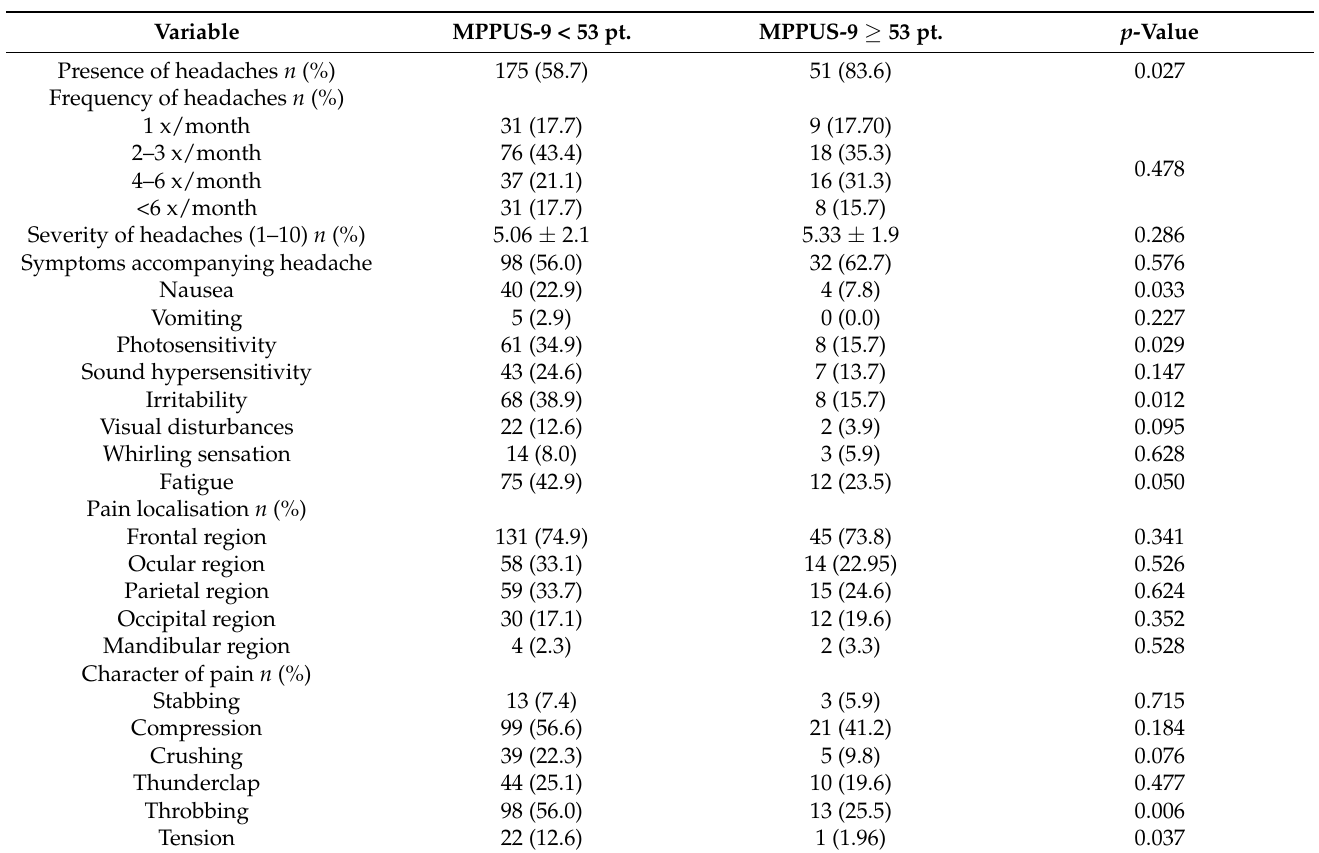
Table 2. Group comparison between individuals that meet the criteria for phonoholism (MPPUS-9 ≥ 53) and a group of participants that does not meet the criteria for phonoholism (MPPUS-9 < 53) regarding the occurrence and characteristics of headaches. Mann–Whitney U tests were performed for quantitative variables, and Fisher’s exact tests were performed for qualitative